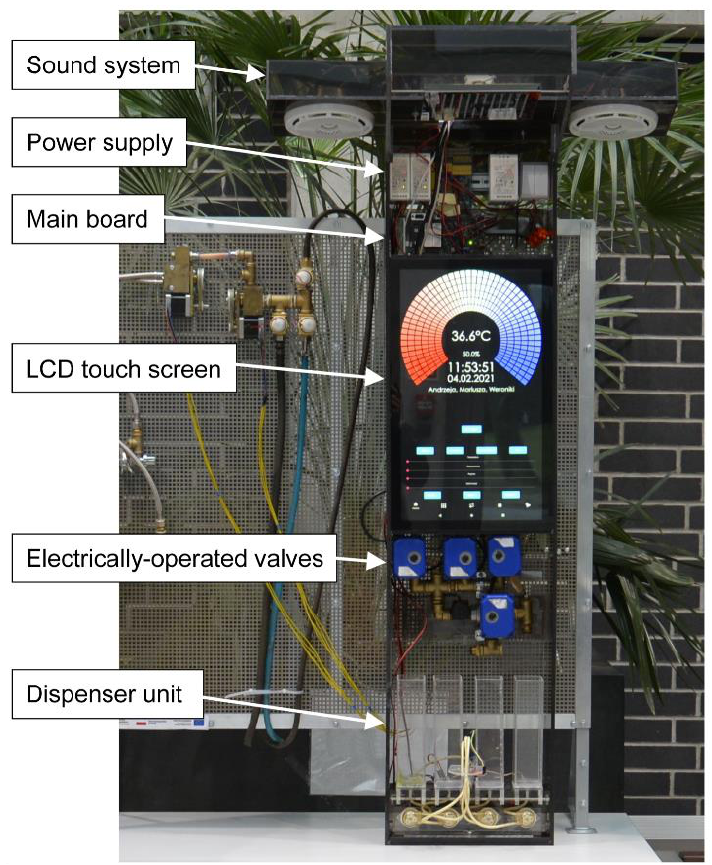
Appl. Sci. 2021 , 11 , 4081 Figure 4. A prototype of the developed interactive shower panel. Figure 4. A prototype of the developed interactive shower panel.